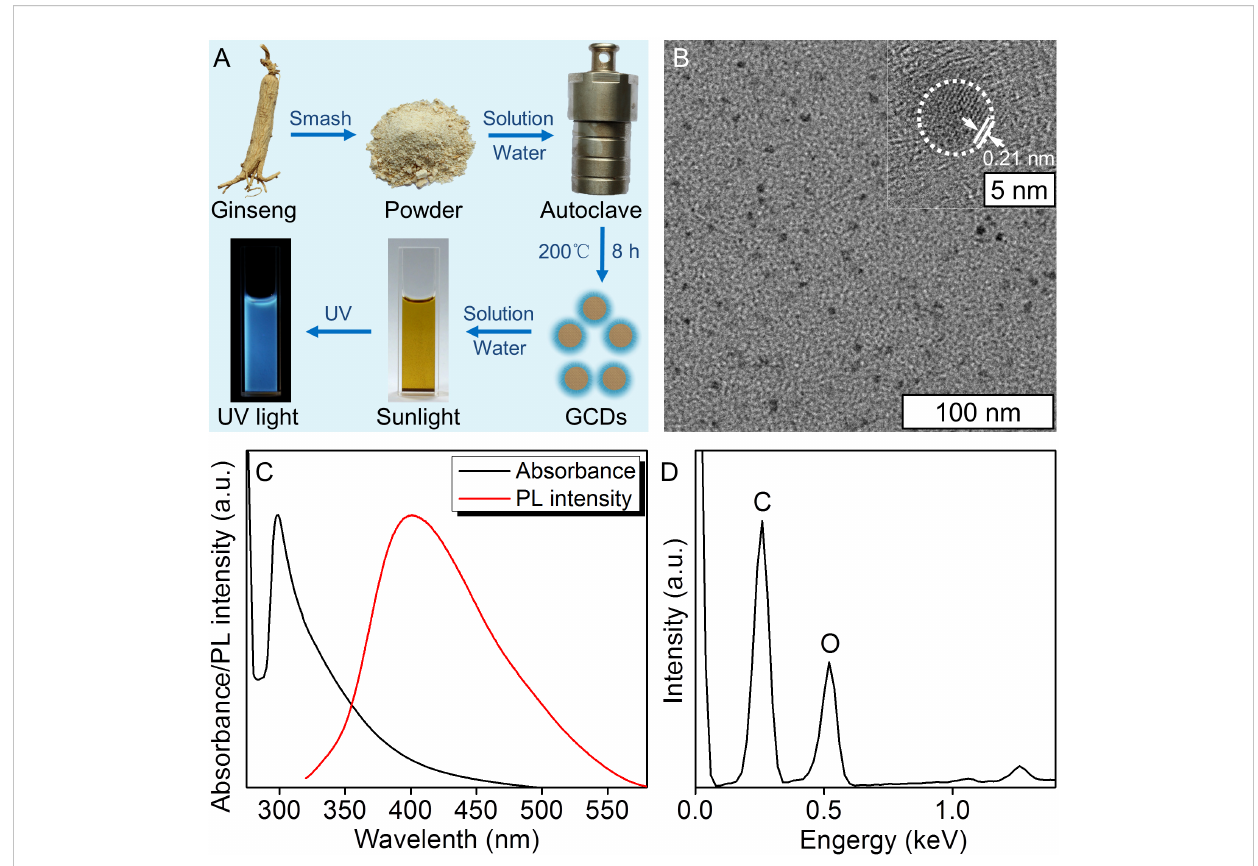
FIGURE 1 Synthesis and characterization of ginseng-based carbon dots (GCDs). (A) Synthesis of GCDs and the sunlight and UV light images of the GCD solution. (B) High-resolution transmission electron microscope (HRTEM) image of GCDs with a diameter of around 4 nm and a lattice structure of 0.21 nm. (C) Photoluminescent (PL) emission and UV-vis spectroscopy of absorption of the GCD solution. The PL emission peaked at 400 nm, and the UV-vis spectroscopy of the absorbance peak was at 298 nm. (D) Energy dispersive spectrum (EDS) of